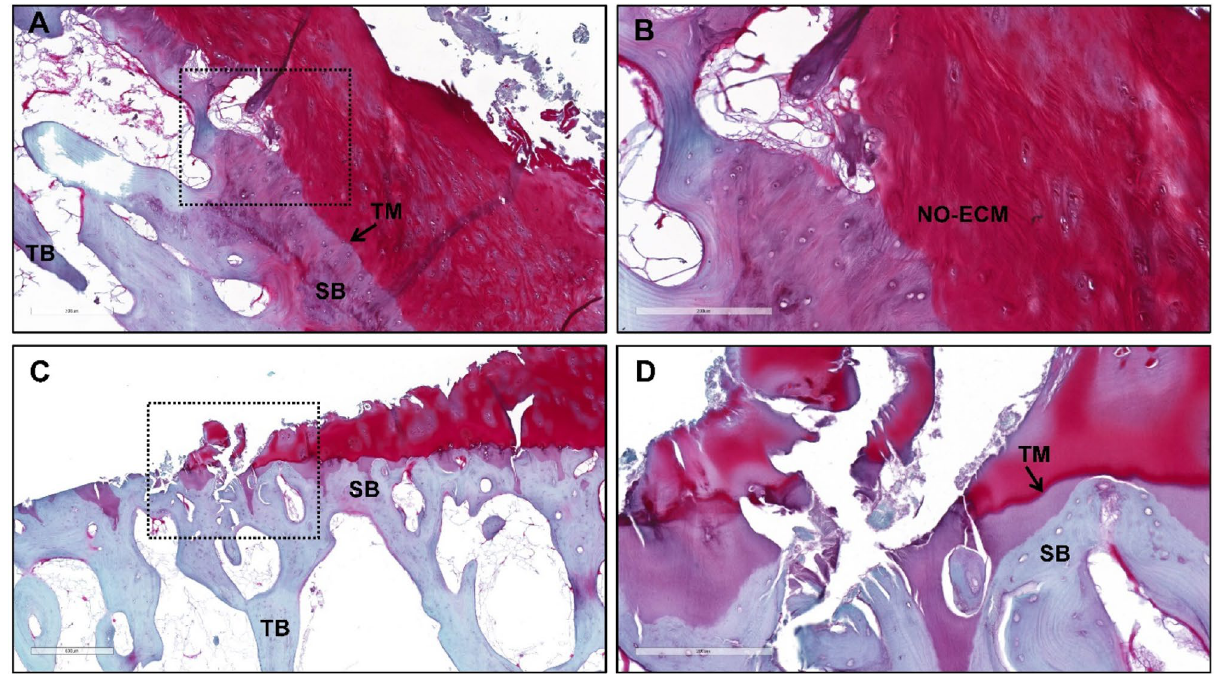
Figure 4. Histological images of the least weight-bearing (LWB; A , B ) and most weight-bearing (MWB; C , D ) of sample#2. SB Subchondral bone, TM Tidemark, NO-ECM non-ordered extracellular matrix,